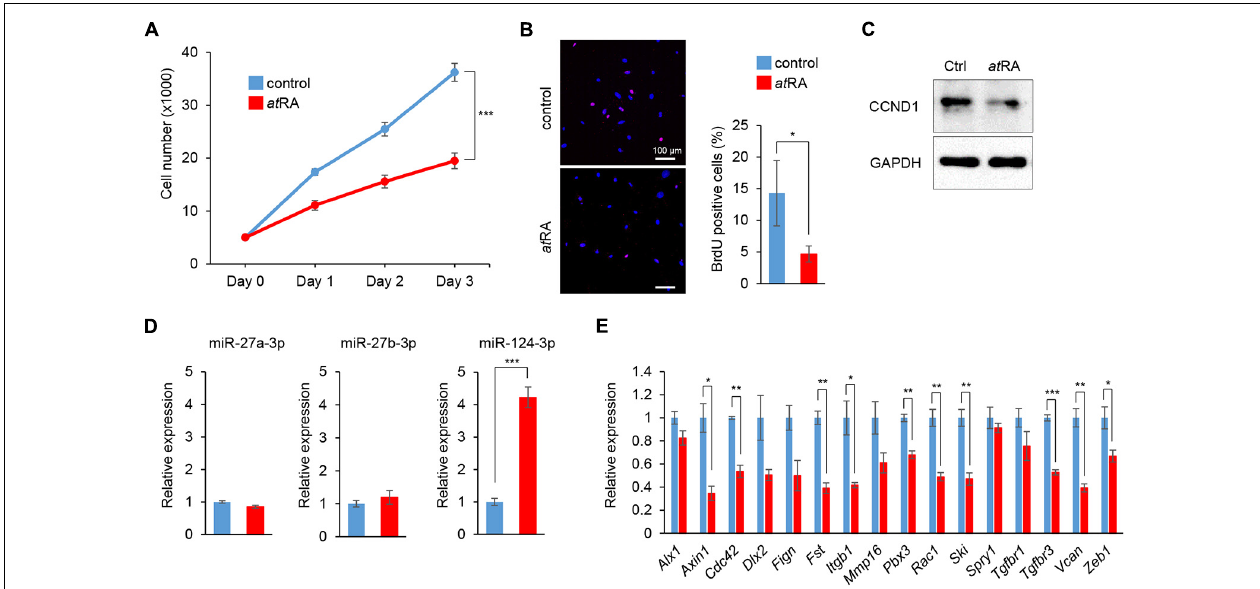
FIGURE 3 | Influence of at RA treatment on cell proliferation and gene expression in MEPM cells. (A) Cell proliferation assays in MEPM cells treated with 30 µ M at RA for 24, 48, and 72 h. Two-way ANOVA with Dunnett’s test ( n = 6). *** p < 0.001 vs. control. (B) BrdU staining (red) in MEPM cells after treatment with 30 µ M at RA for 72 h. Nuclei were counterstained with DAPI (blue). Representative images from two independent experiments are shown. Graph shows the quantification of BrdU-positive cells. Independent t -test. * p < 0.05 vs. control. Bars, 50 µ m. (C) Immunoblotting analysis of CCND1 and GAPDH in MEPM cells treated with 30 µ M at RA for 72 h. Representative images from two independent experiments are shown. (C) Immunoblotting analysis for CCND1 in MEPM cells treated with 30 µ M at RA for 72 h. GAPDH was used as an internal control. (D) Quantitative RT-PCR for miR-27a-3p, miR-27b-3p, or miR-124-3p after treatment with at RA for 24 h in MEPM cells. Multiple t -tests adjusted by Bonferroni ( n = 3). ***Adjusted p < 0.00033 (three miRs). (E) Quantitative RT-PCR for the indicated genes after treatment with at RA for 24 h in MEPM cells. Multiple t -tests adjusted by Bonferroni ( n = 3–6). *Adjusted p < 0.00313 (16 genes), **adjusted p < 0.000625 (16 genes), ***adjusted p < 0.0000625 (16 genes) vs.